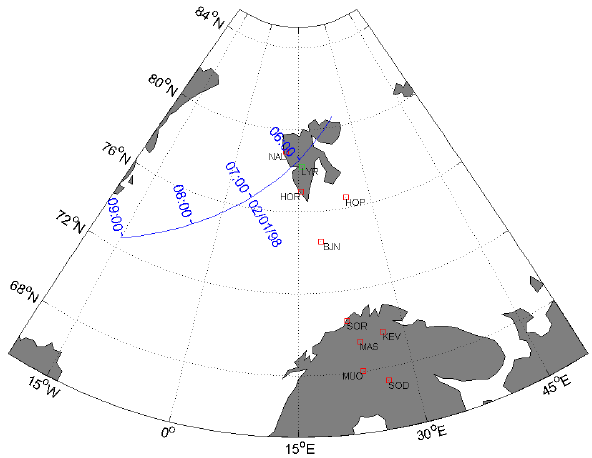
Fig. 1. Observational configuration of 1 February 1998 showing Geotail projected orbit in the Northern Hemisphere’s ionosphere (in blue), the EISCAT Svalbard Radar and the neighbouring IM- AGE station in Longyearbyen (in green) and the nine other IMAGE stations (in red).